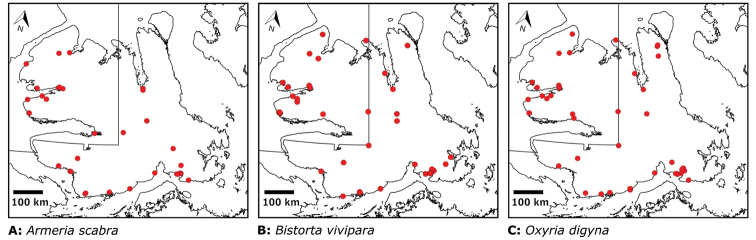
Species distribution maps. Plumbaginaceae: AArmeria
scabra. Polygonaceae: BBistorta
viviparaCOxyria
digyna.